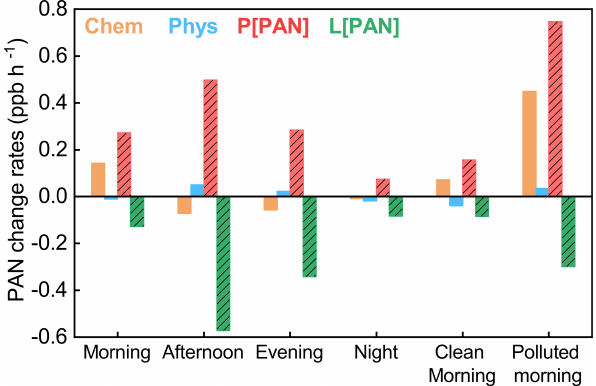
Figure 6. Process diagnostic analysis of PAN on average and in the morning on clean and polluted days. Chem, Phys, P [PAN], and L [PAN] denote the net chemical production, physical changes, chemical production, and loss rates of PAN, respectively. Morning, afternoon, evening, and night correspond to 08:00–12:00, 12:00– 16:00, 16:00–20:00, and 20:00–08:00LT,